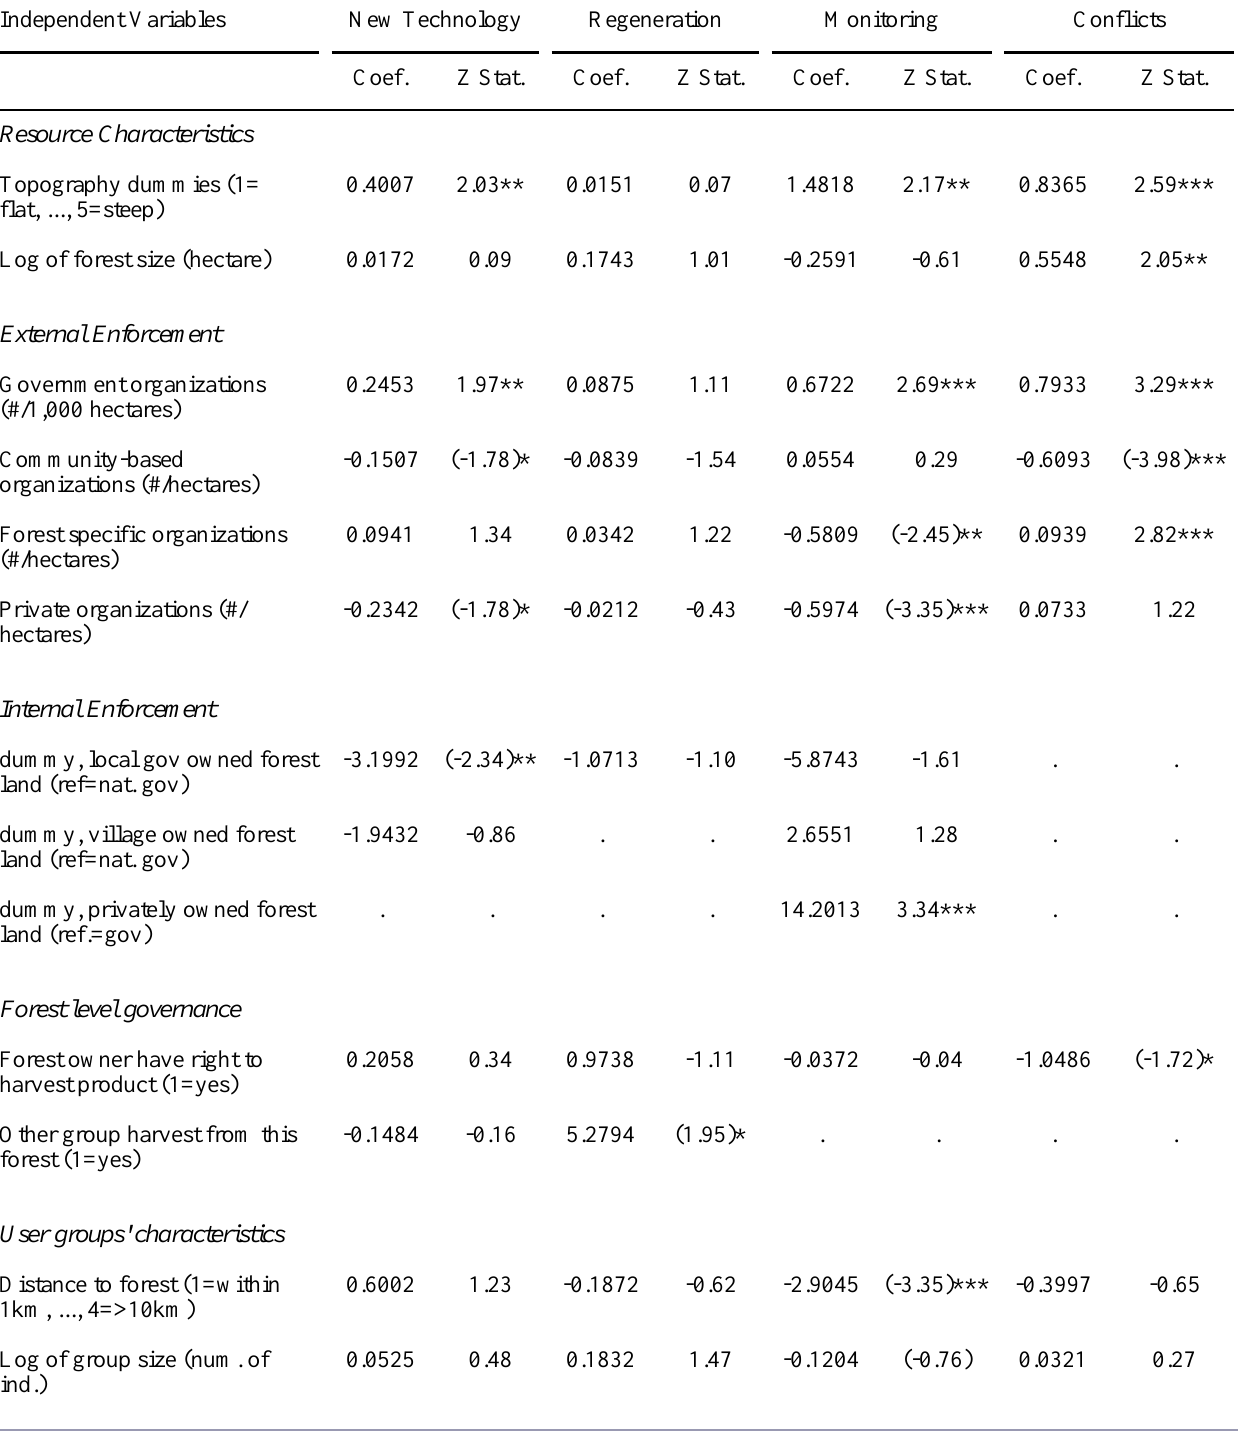
Table 3. Probit estimates of user groups' behavior. Independent Variables New Technology Regeneration Monitoring Conflicts Coef. Z Stat. Coef. Z Stat. Coef. Z Stat. Coef. Z